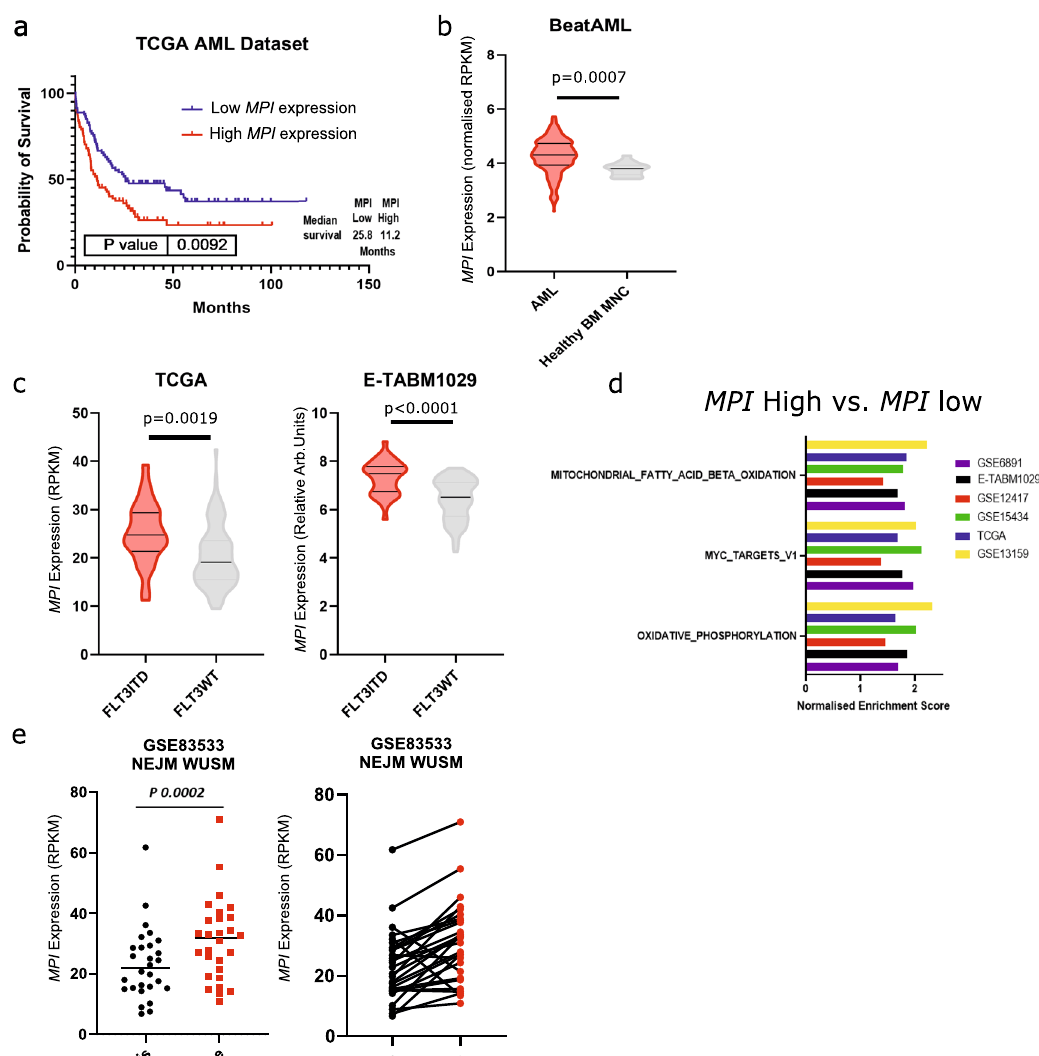
Fig.1|HighMPIexpressioncorrelateswithworseprognosisinAMLandagene signature associated with enhanced oxidative phosphorylation and fatty acid metabolism. a Kaplan-Meier curve comparing survival of patients from the TCGA AML cohort separated by the top 50% and bottom 50% of MPI expression (data obtainedfrom https://www.cbioportal.org/).Log-rank (Mantel-Cox) test; ( b ) Violin plots of normalised MPI expression in AML samples compared to normal, healthy bone marrow mononuclear cells (MNC) from the BeatAML dataset (data obtained http://www.vizome.org/).Unpaired t test,twosided. N =437AML, N =19forhealthy BM MNC; ( c ) Violin plots comparing MPI expression in FLT3 ITD and FLT3 WT AML